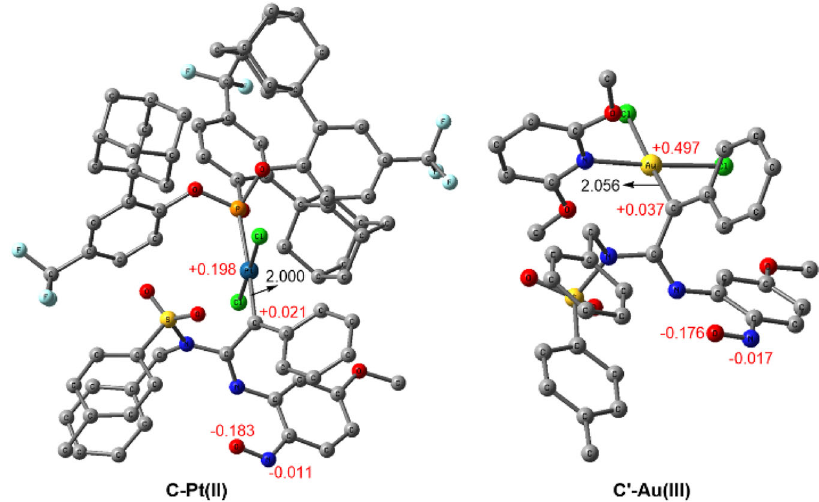
Fig. 9 Gold(III) and Platinum(II) carbene intermediates. Selected bond lengths (black, Å) and CM5 atomic partial charges (red, au) for optimized geometries of Pt(II) and Au(III) carbene species. Hydrogen atoms are omitted for